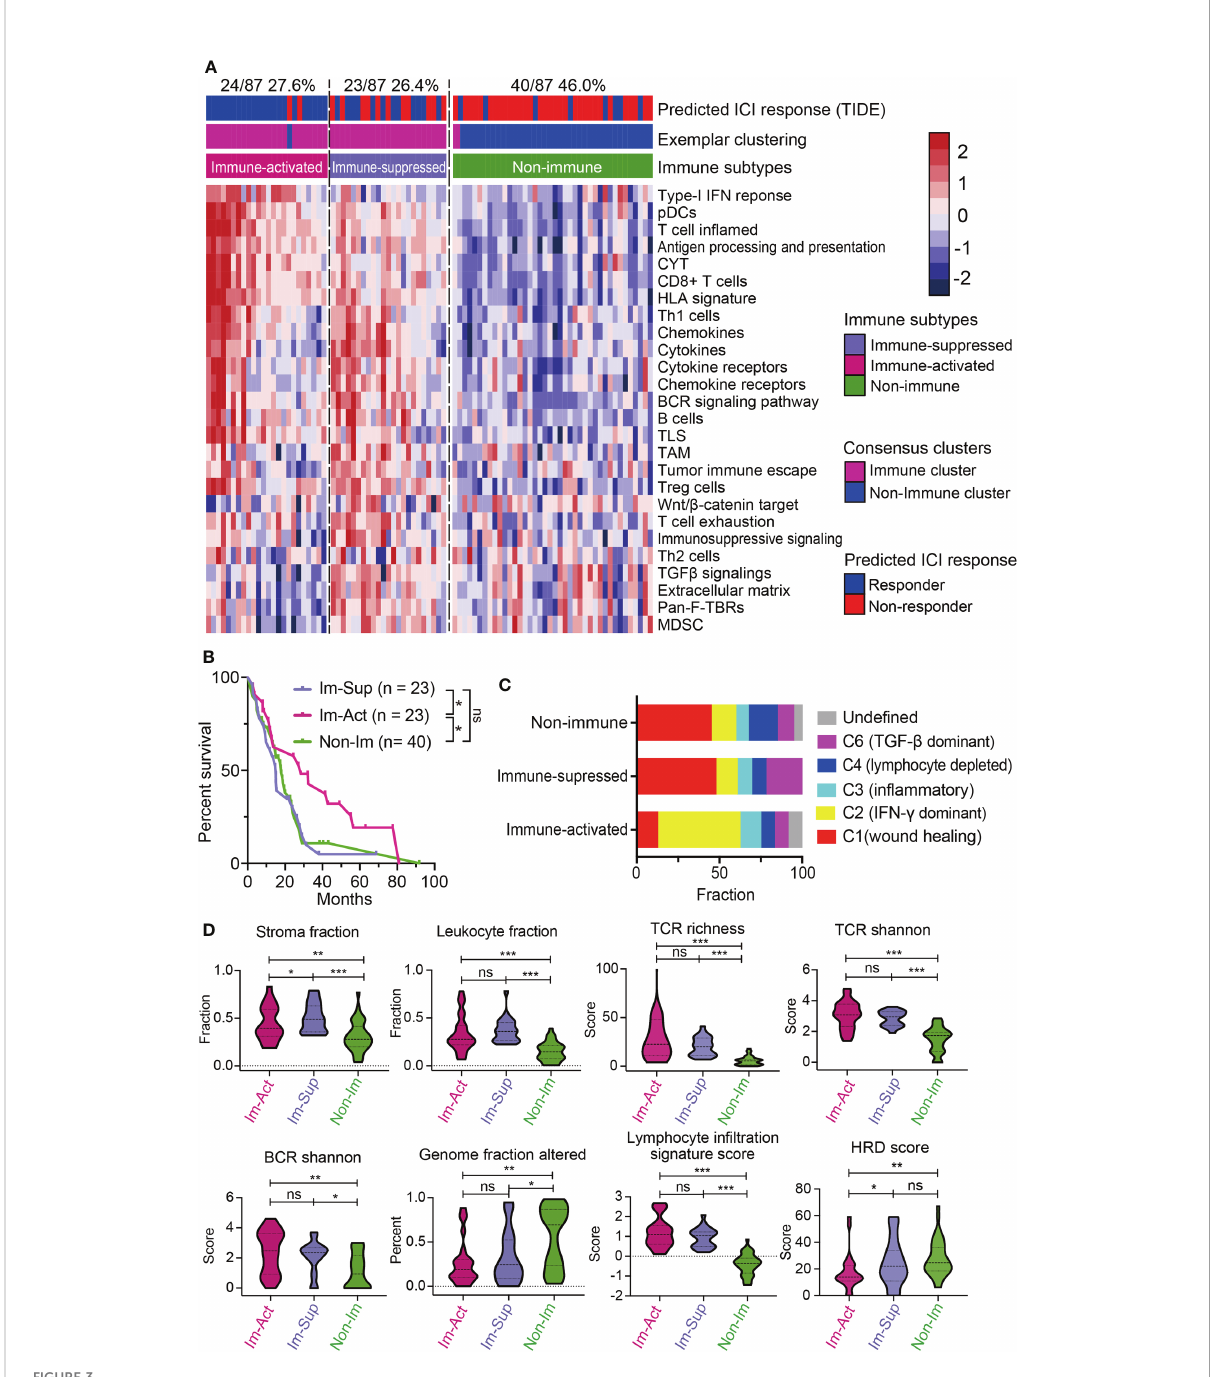
FIGURE 3 Validation of the novel immune-subtyping in external MPM cohort. (A) The TCGA-MPM cases were subdivided into non-immune (40/87, 46.0%), immune-suppressed (23/87, 26.4%), and immune-activated (24/87, 27.6%) MPMs using methods of consensus clustering, MDS-RF modi fi cation, and NTP division with signatures covering 26 immune- and TME-related signatures which were shown in the heatmap. Top column shows the predicted ICI response estimated by IOBR and corresponding immune subtype of each case. (B) Kaplan-Meier survival analyses of overall survival in MPMs with different immunological subtypes using TCGA RNA-seq cohort. **, p < 0.01; *, p < 0.05; n.s., Not signi fi cant. (C) Percentage column plots showing the distribution of predicted Thorsson ’ s pan-cancer immune phenotyping across the three immune subtypes. ***, p > 0.001; **, p > 0.01; *, p > 0.05; n.s., Not signi fi cant. (D) Scoring or fraction of immune cell components and indices in different immune